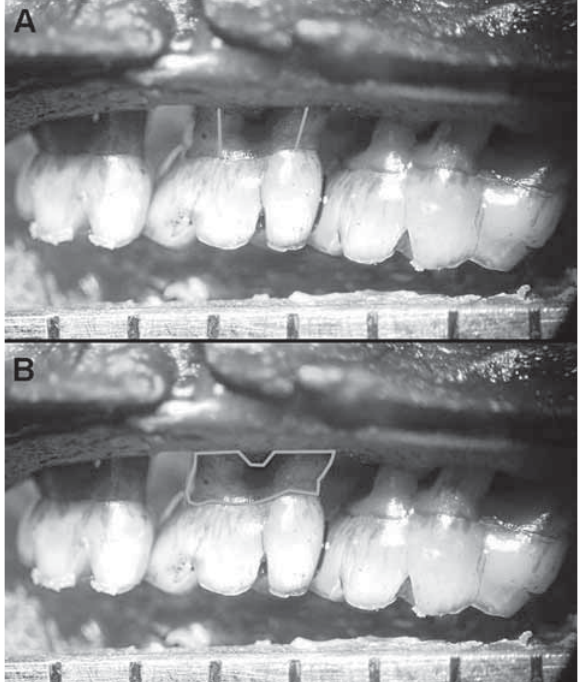
Figure 2- Photograph of alveolar bone loss evaluated morphometrically by measuring the linear distance between the cementoenamel junction and alveolar bone crest at two palatal sites on the maxillary second molar (cid:1)(cid:2)(cid:3)(cid:4)(cid:5) (cid:6)(cid:7)(cid:8)(cid:5) (cid:9)(cid:10)(cid:8)(cid:9)(cid:5) (cid:11)(cid:8)(cid:12)(cid:7)(cid:13)(cid:14)(cid:5) (cid:15)(cid:9)(cid:16)(cid:5) (cid:14)(cid:8)(cid:17)(cid:18)(cid:8)(cid:14)(cid:5) (cid:19)(cid:20)(cid:5) (cid:14)(cid:8)(cid:21)(cid:22)(cid:11)(cid:22)(cid:12)(cid:9)(cid:12)(cid:22)(cid:13)(cid:18)(cid:5) (cid:13)(cid:23)(cid:5) the area of bone loss using the alveolar bone crest, the cementoenamel junction and the proximal region of roots of the maxillary second molar on the palatal side as